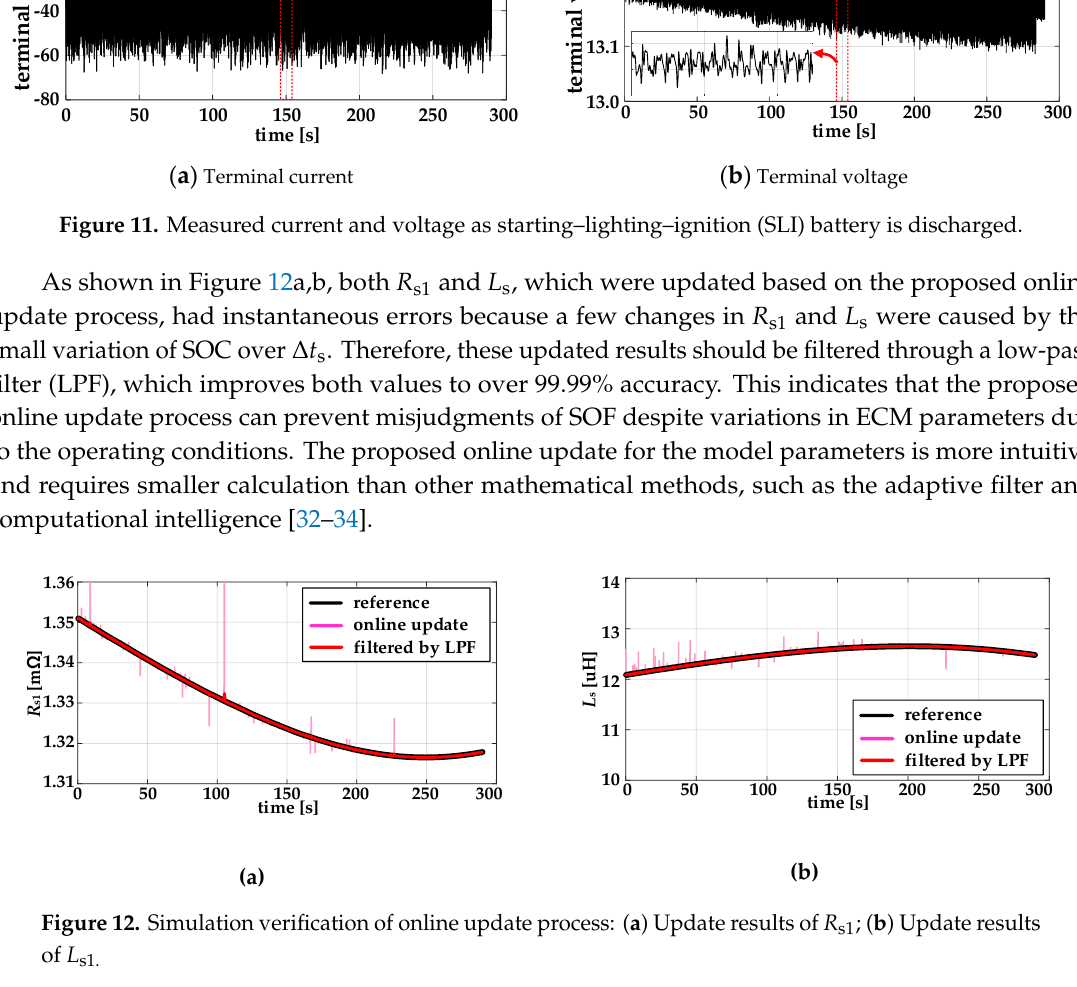
Figure 12. Simulation verification of online update process: ( a ) Update results of R s1 ; ( b ) Update results Table 1. Specification of battery pack. of L